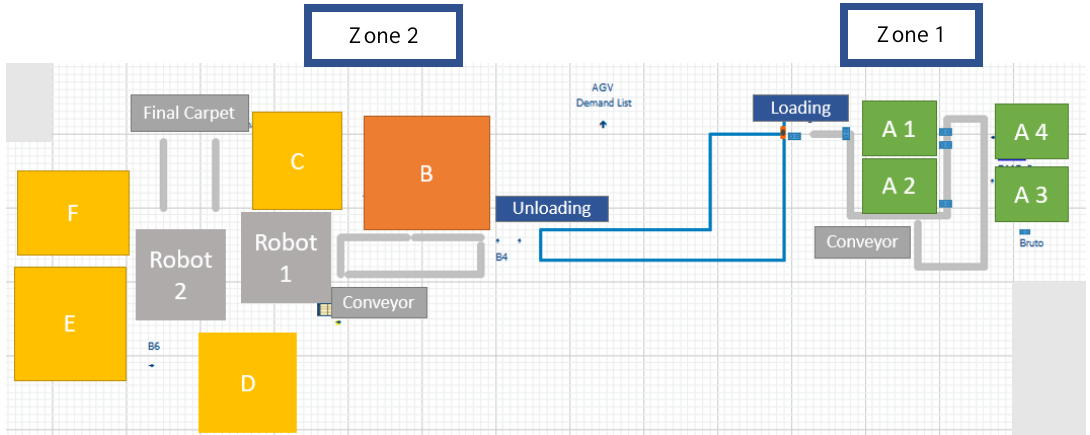
Figure 4. Layout 2 (Machine A in Zone 1 and Machine B in Zone